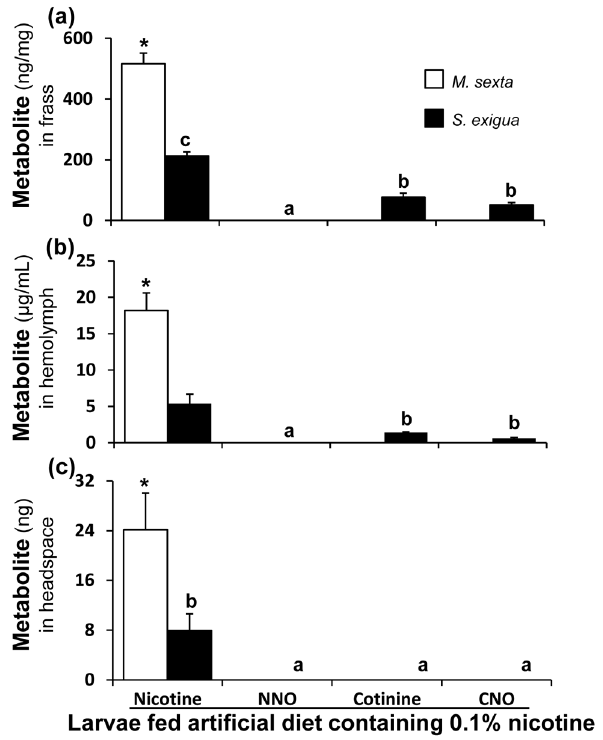
Figure 3. S. exigua oxidizes nicotine, but M. sexta does not. U(H)PLC/ESI-QTOF-MS-based quantitative analysis of nicotine, NNO, cotinine and CNO in ( a ) frass ( b ) hemolymph and ( c ) headspace of third-instar M. sexta (n=5) and S. exigua (n=5) larvae fed artificial diet containing 0.1% (fresh mass) nicotine. Lower-case letters above the S. exigua bars indicate significant differences ( P # 0.05) among them, by one-way ANOVA. Asterisks above the M. sexta nicotine bars indicate that they differ significantly ( P # 0.05) from the S. exigua nicotine values, as determined by one-way ANOVA. Nicotine oxides were not detected in M. sexta . The detection limit of nicotine was 0.25 ng and 0.5 ng for cotinine, CNO and NNO; efficiency of extraction was . 90% for all these